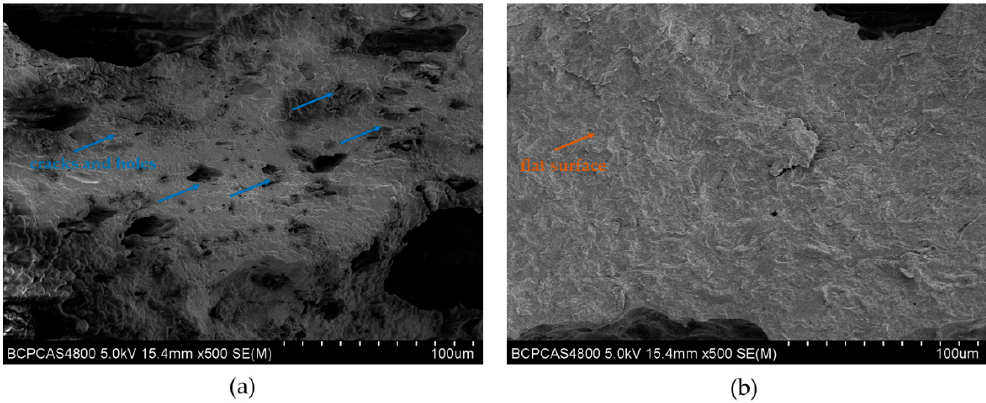
Figure 4. SEM images of the adhesive control ( a ) and the soybean meal-based adhesive with 4 wt% DRE ( b ).